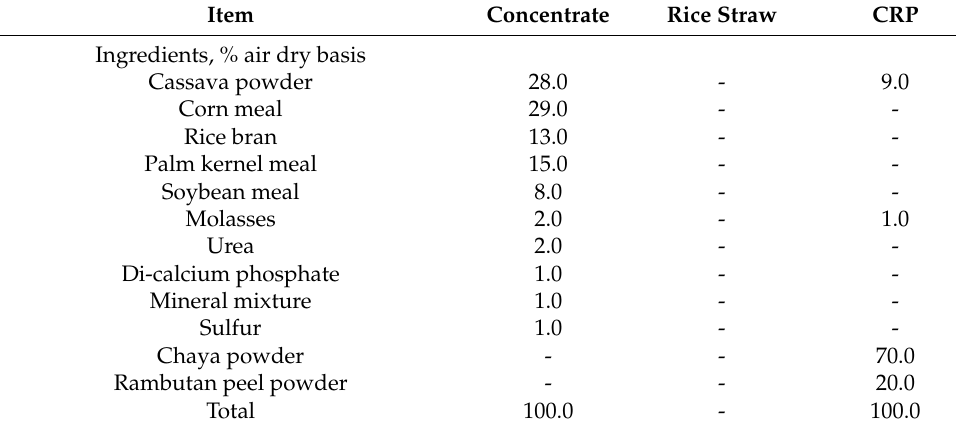
Table 1. Feed ingredients and chemical composition of the experimental